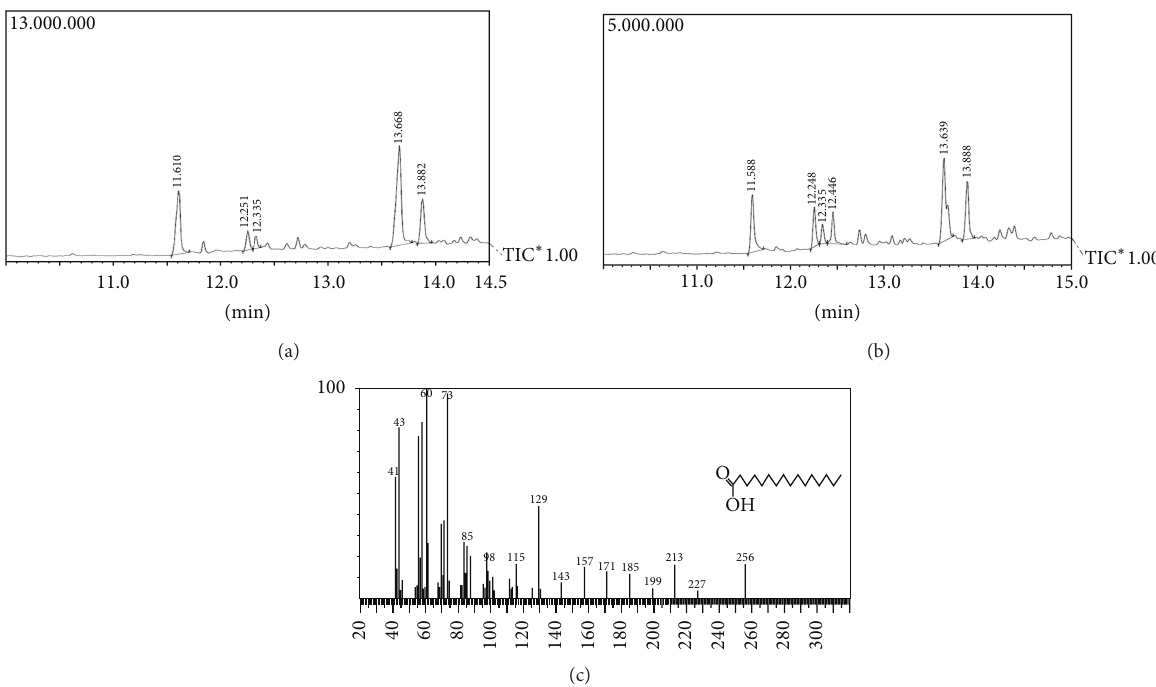
Figure 5: GC/MS analysis of poly(3HB) purified from NAP11 and NAC1 isolates. (a) GC of NAP11 showing main peak at 13.667 min of 3HB dimer. (b) GC of NAC1 showing main peak at 13.667 min of 3HB dimer and 3 other peaks indicating the presence of 3HV in the purified polymer. (c) MS graph showing that the major peak at m/z 73 is of hexadecanoic